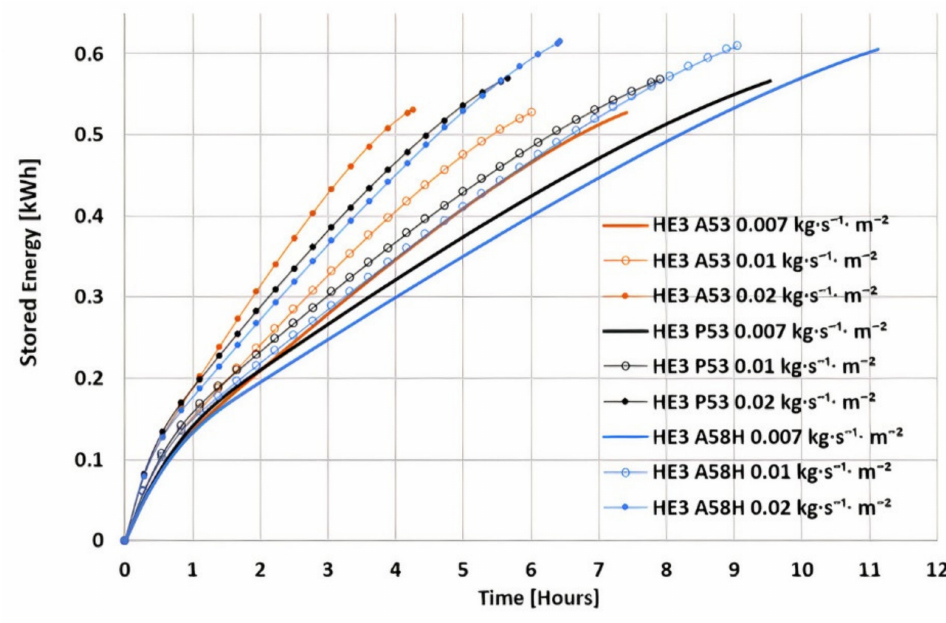
Figure 12. Stored energy during charging for all PCMs and all HTF flow rates studied, for